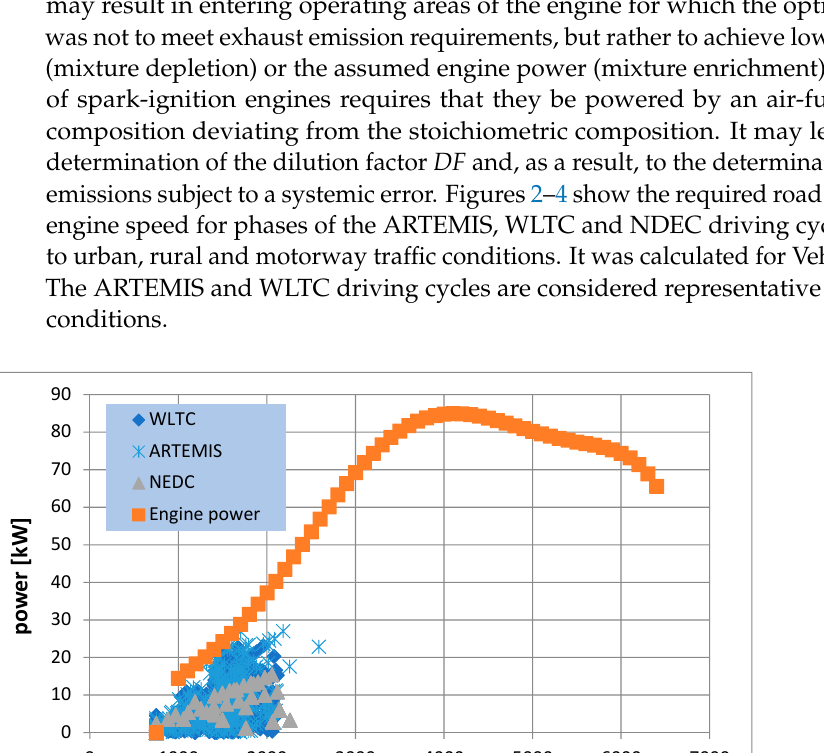
Figure 1. Error in determining the dilution factor DF depending on the λ [8].